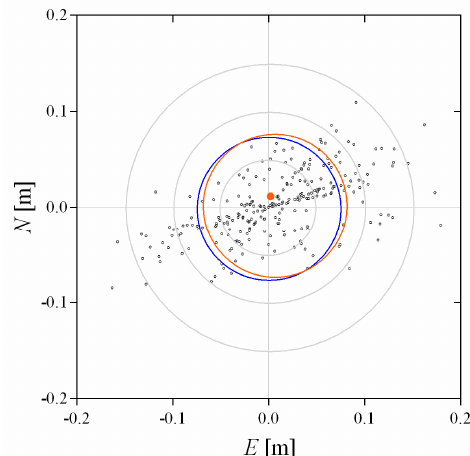
RMSE [56], were not exceeded by any di ff erences.